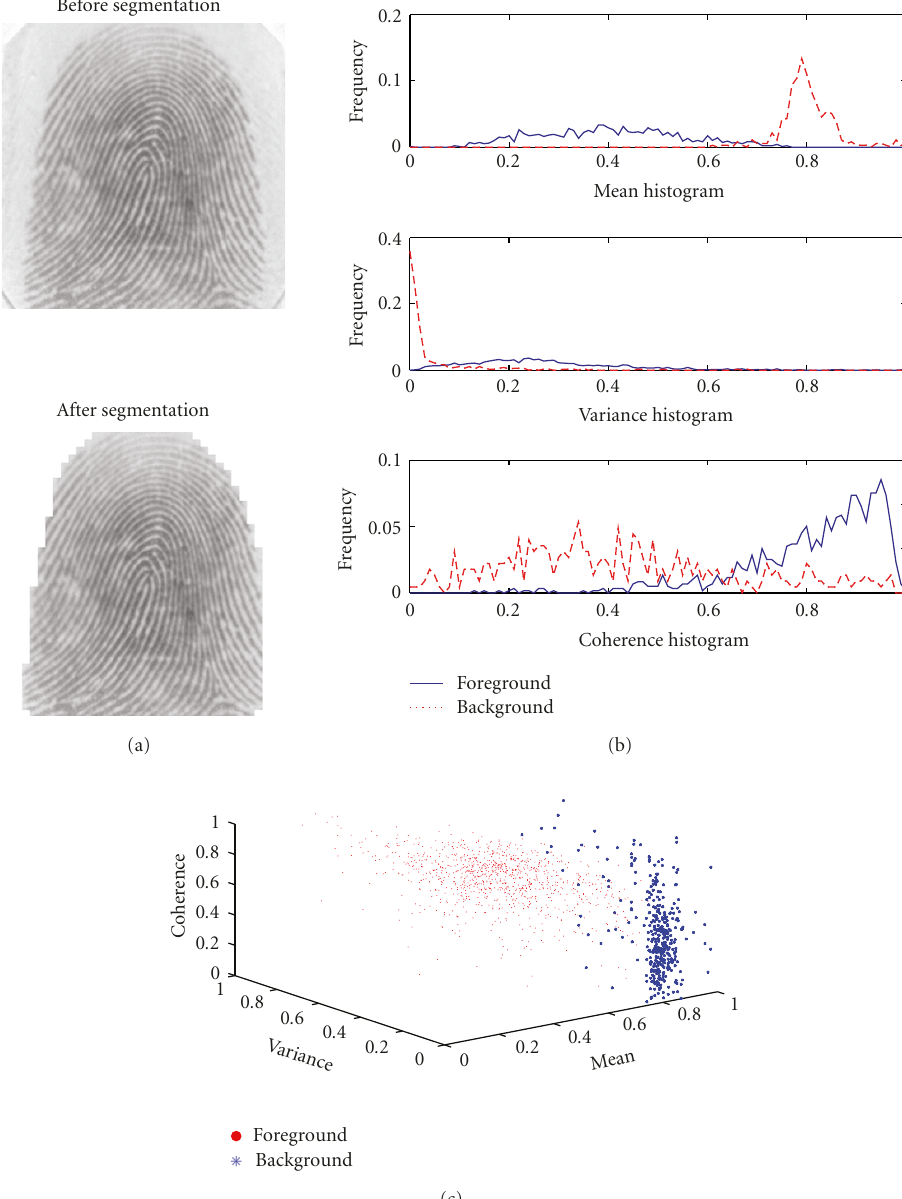
Figure 2: CMV histograms and distribution of FVC2000 DB1 81